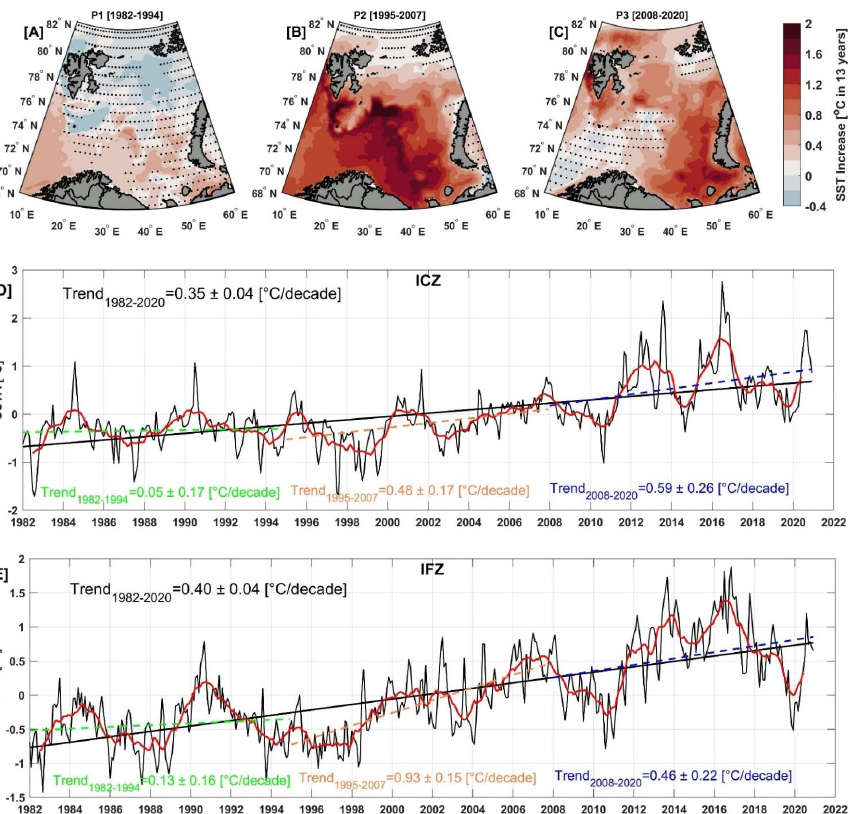
Figure 9. Spatial distribution of the de-seasoned trends of SSTA for the periods; ( A ) P1 (1982 – 1994), ( B ) P2 (1995 – 2007), and ( C ) P3 (2008 – 2020), respectively. Regions where the trends are not statisti- cally significant at the 95% confidence interval (after Mann – Kend all’s test) are stippled. De-seasoned monthly mean time series of spatially averaged SSTA over ( D ) the ice-covered zone (ICZ) and ( E ) the ice-free zone (IFZ) from 1982 through 2020. Trends for each period (colored dashed lines) and for the entire period (black solid line) are also shown. To enhance the visualization and to emphasize interannual variability, the data was low-passed using a 13-month moving average (red line).